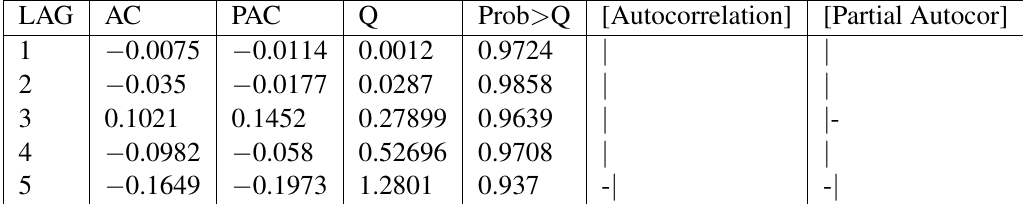
Table 3 Residual autocorrelation and partial autocorrelation test of green patent